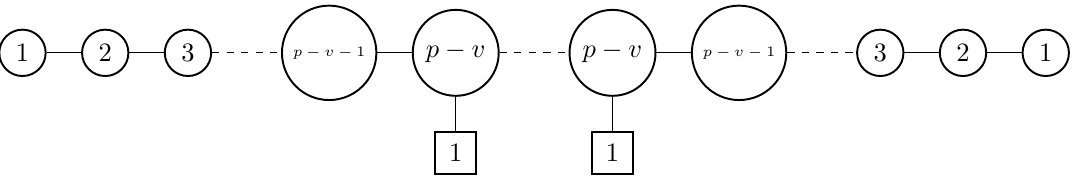
Figure 11 . Higgs branch quiver for M ( B; v ) in a SU(2) theory for B = ( (cid:0) p; p ) and v = ( (cid:0) v; v ) as deduced from the D3-D1-NS5-brane system. The quiver is the same as the one given in (cid:12)gure 4 with p ! 2 p; v ! 2 v